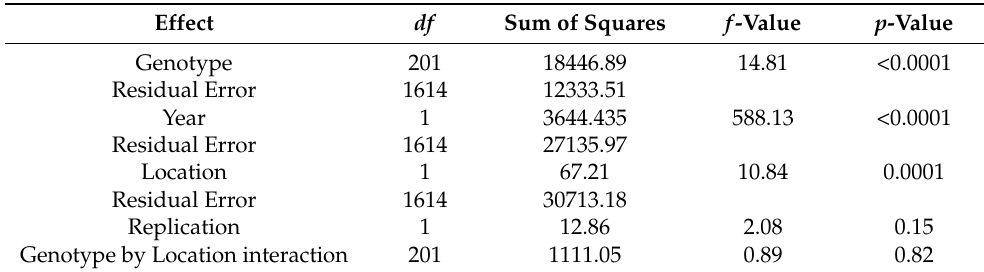
Table 3. Analysis of variance of Kunitz trypsin inhibitor concentration (KTI) among 200 F 3:4 lines (2016) and 200 F 3:5 lines (2017) as well as parents Glenn (normal KTI) and PI 547,656 (low KTI) planted in Blacksburg and Orange,